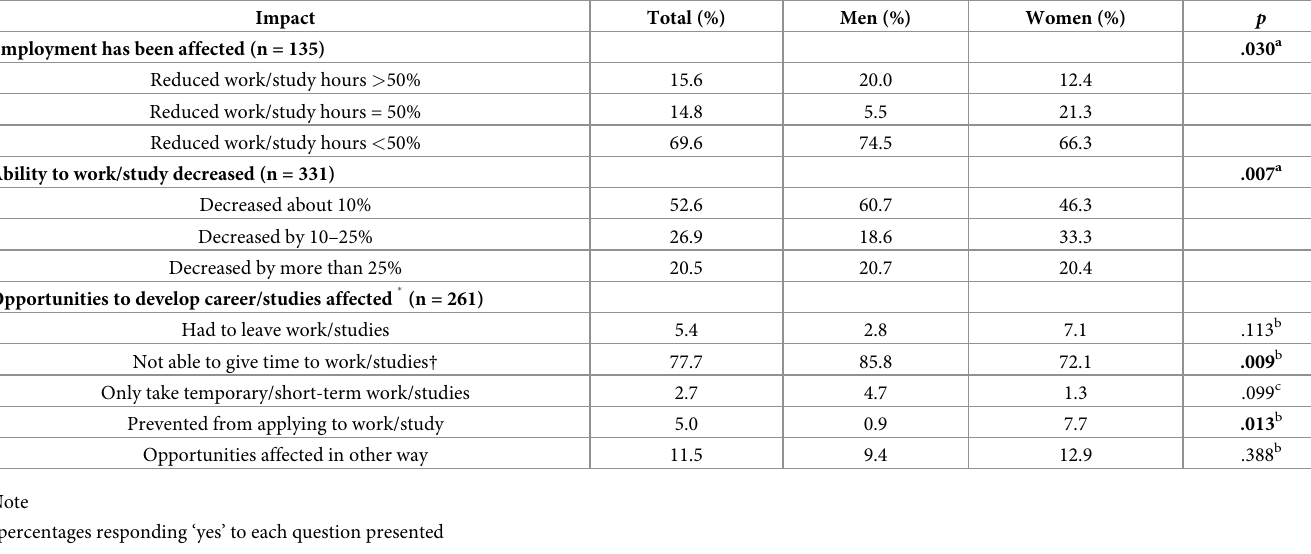
Table 3. Impact of providing care and support on work/study among working carers: Associations with